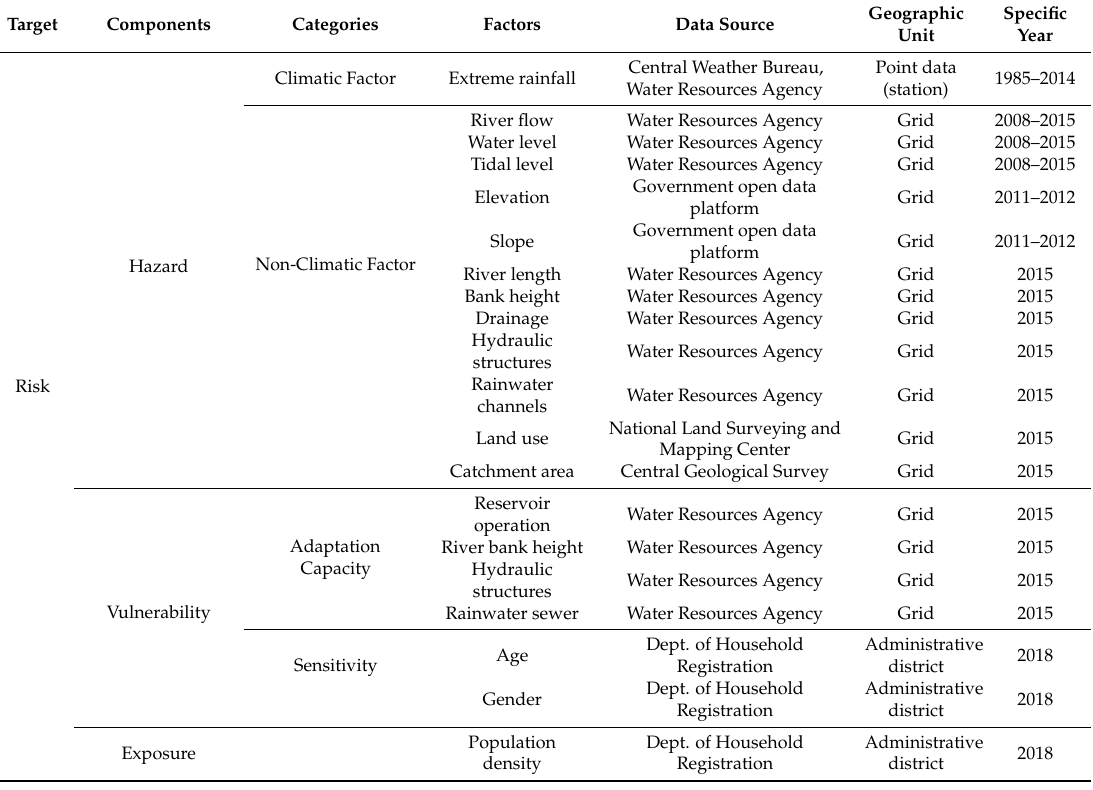
Table 3. The corresponding number for each administrative district of the study